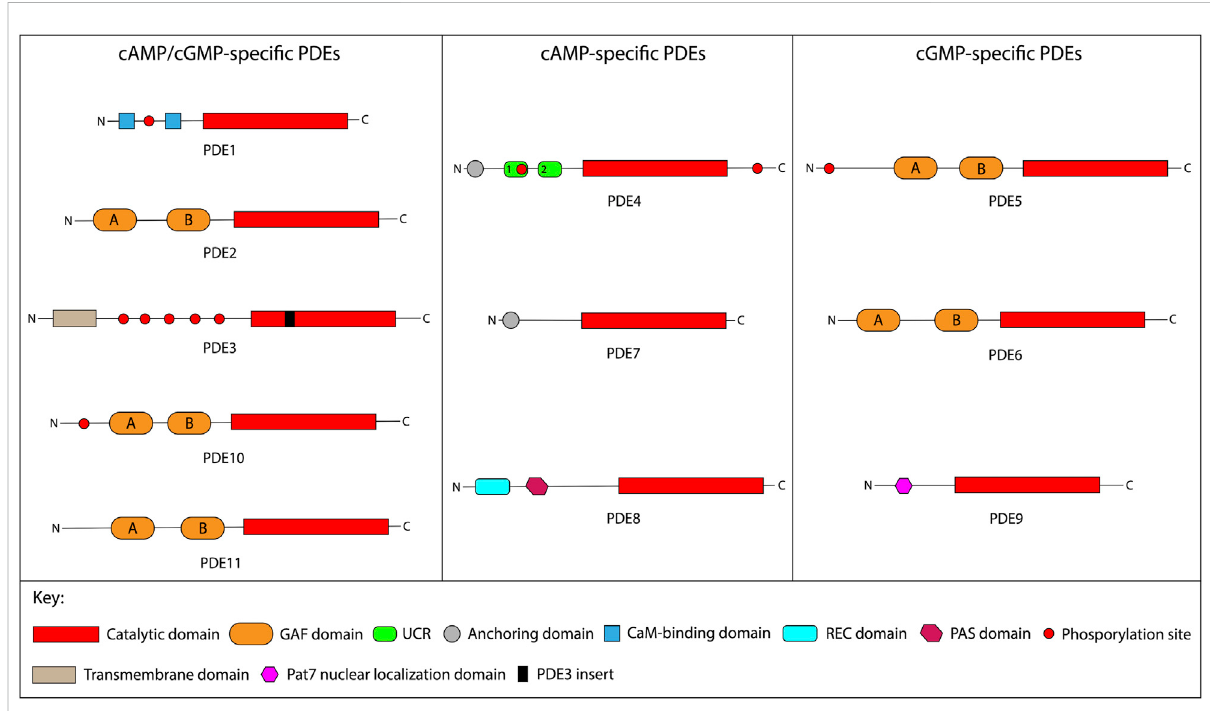
FIGURE 1 Schematic structure of PDE enzymes. This fi gure schematically presents principle structural features of the individual PDE isoforms. The PDE families are grouped according to the cyclic nucleotide af fi nities. The structural features and approximate isoform sizes of each PDE family are summarized as per (Baillie et al., 2019; Conti and Beavo, 2007; Francis et al., 2011; Maurice et al., 2014). Abbreviations: cAMP, cyclic adenosine monophosphate; cGMP, cyclic guanosine monophosphate; PDE, phosphodiesterase; GAF, cGMP-binding PDEs, Anabaena adenylyl cyclase,